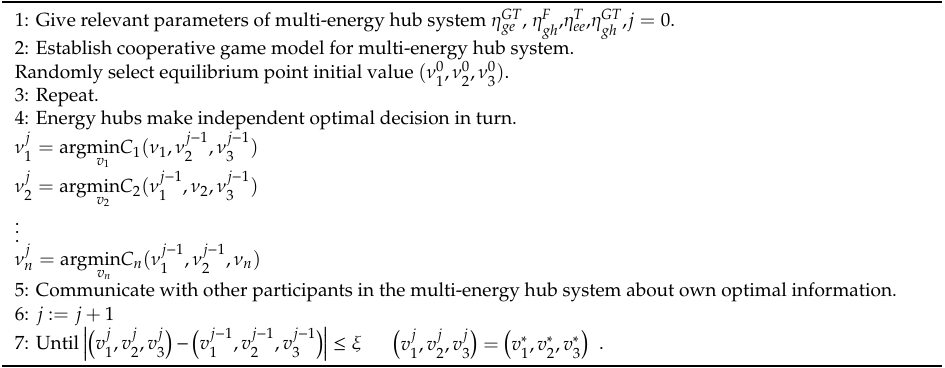
, j = 0. , η T ee , η GT gh gh ) . , ν 0 , ν 0 2 3 1